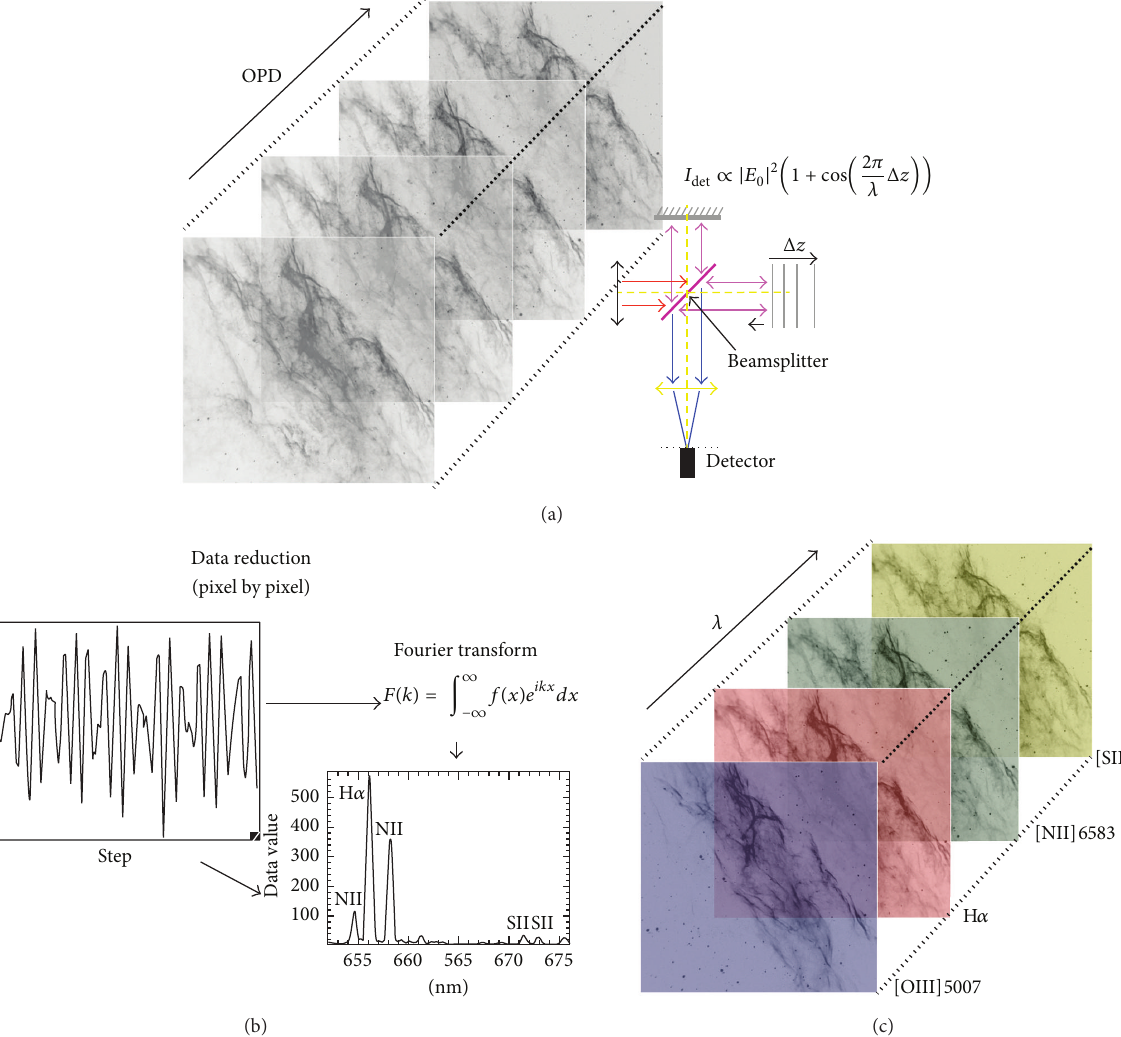
Figure 1: Data acquisition with an imaging FTS. (a) By scanning the Optical Path Difference (OPD) of the interferometer and taking images at every step, one gets a datacube composed of one interferogram for every pixel. (b) For a given pixel, the recorded intensity varies as a function of the OPD with a pattern that depends on the spectral content of the source; for example, a monochromatic laser beam would produce a sinusoidal pattern. A Fourier transform of the signal produces a spectrum for every pixel in the image. (c) After Fourier transforming every interferogram, one gets a spectral datacube from which monochromatic images corresponding to the emission lines of interest are